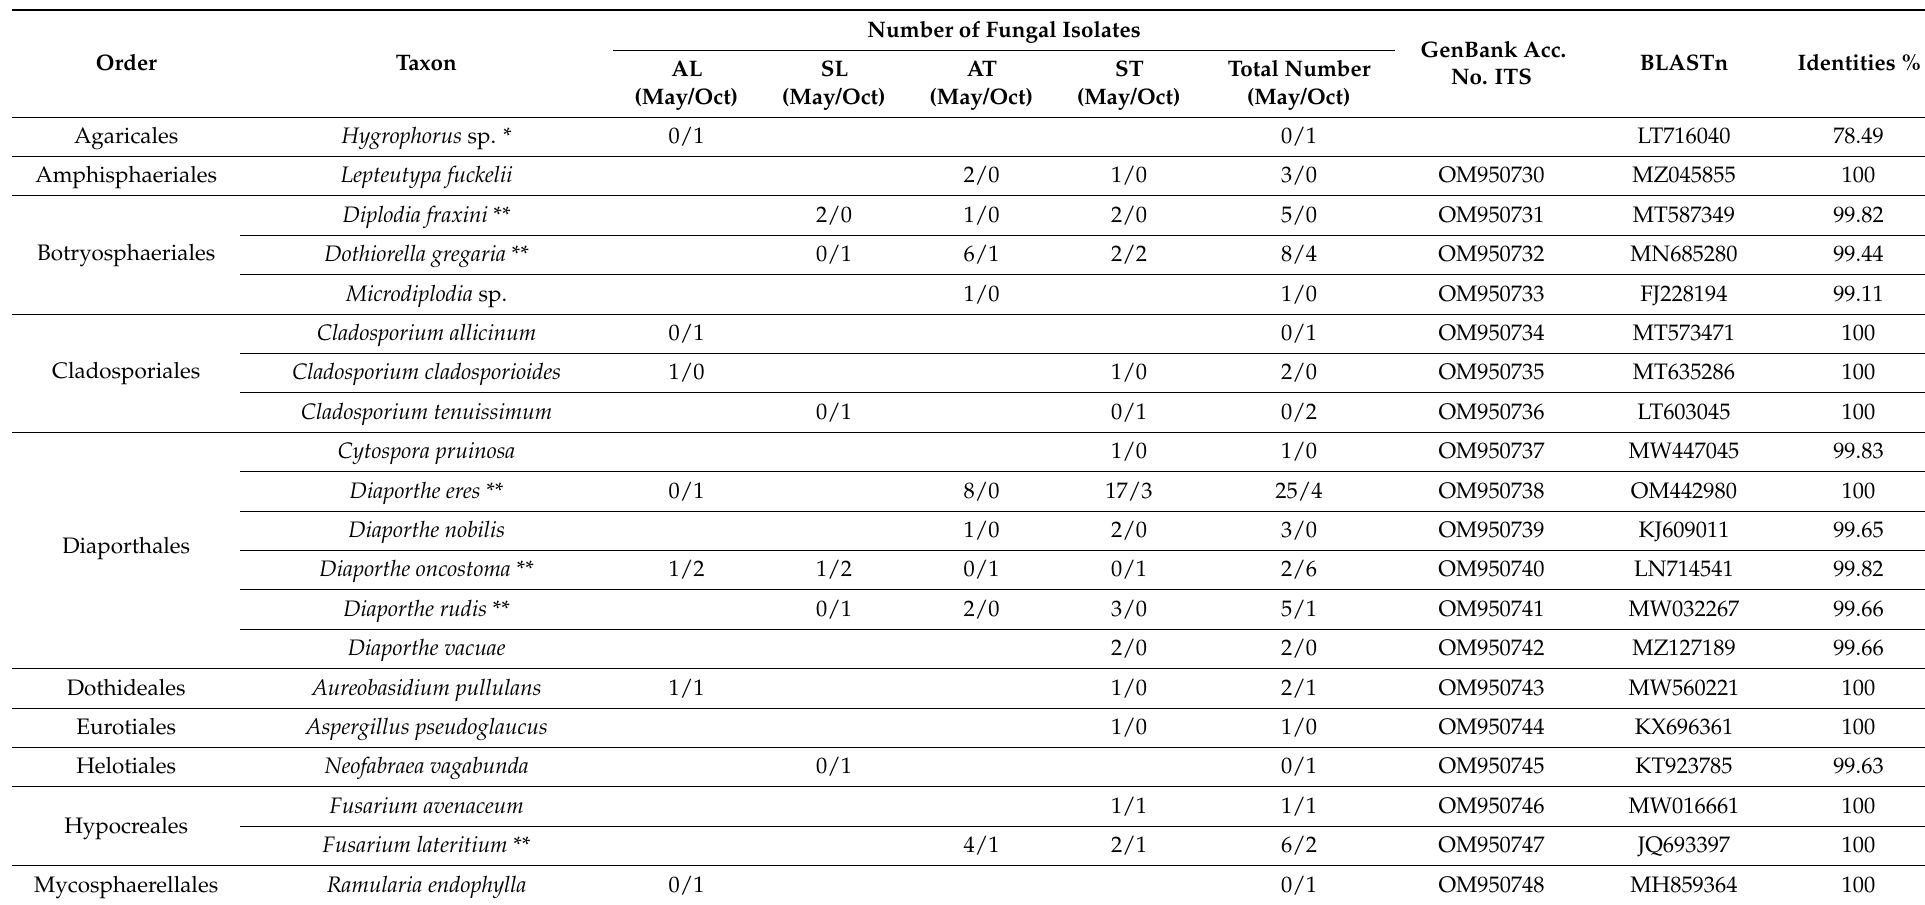
Table 2. Endophytic fungi identified from leaves and twigs of ash trees displaying (symptomatic) or not displaying (asymptomatic) symptoms of ash dieback disease collected in Slovakia in May and October